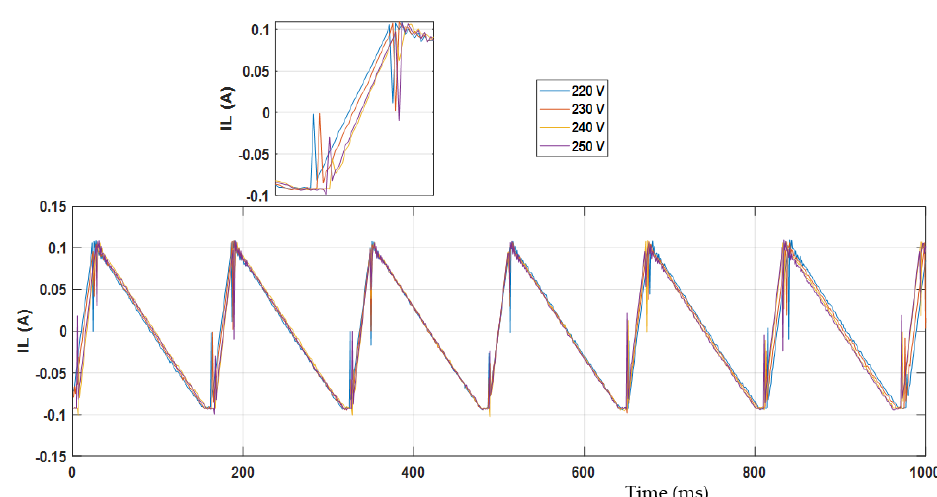
Figure 11. Current through the reactance, for four different mains voltages; Type A lamp.